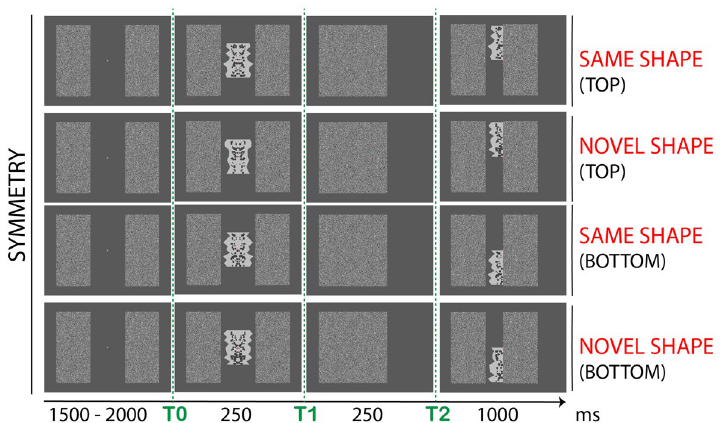
Figure 4. Example of stimuli and procedure in Experiment 2. The sequence of events was same as in Experiment 1, but position of the second polygon in t2 was either above or below the fixation dot (counterbalanced across trials). For simplicity, the figure illustrates only symmetric shapes and displacement of the right occluder. Same stimulus combinations were obtained for asymmetric shapes and left occluder (all counterbalanced across trials).